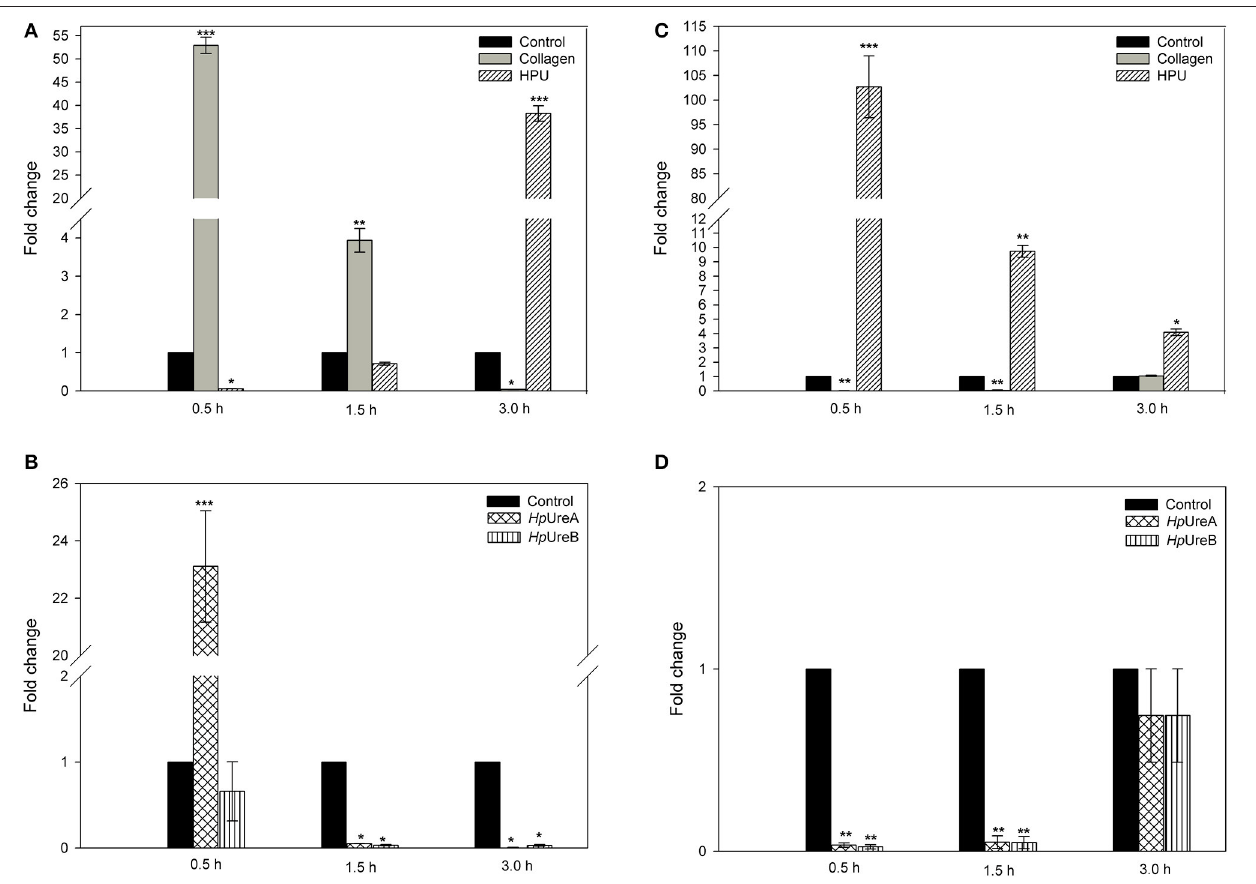
FIGURE 5 | HPU and its isolated subunits modify human platelet’s mRNA processing. Platelets were treated with 50 µ g.mL − 1 of collagen, 100nM HPU, 100nM HpUreA, or 100nM HpUreB for 0.5, 1.5, and 3h at 37 ◦ C, without stirring. Untreated platelets were taken as the negative control. mRNA processing was evaluated by RT qPCR using primers designed to span exon junctions. (A,B) IL-1 β mRNA processing. (C,D) CD 14 mRNA processing. Results are shown as means ± SEM of three independent biological replicates, performed in quadruplicates. A t -test was performed to compare treatments with the control (buffer). Values of * p < 0.05, ** p < 0.01, *** p <